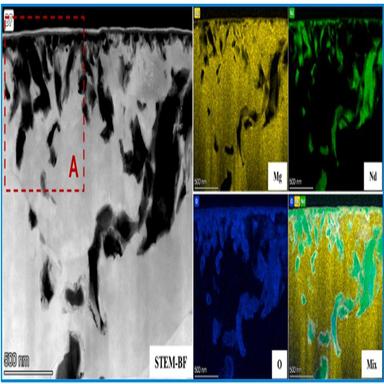
(a) STEM-BF image and corresponding EDS elemental distribution maps of the region occupied by Mg12Nd precipitate after oxidation for 1 h; (b) enlarged STEM-BF image and corresponding EDS elemental distribution maps of Region A in; (c) EDS line-scan 1 showing the elemental distribution across the oxide precipitate in (b); (d) HRTEM images of Mg matrix, MgO, and Nd2O3.